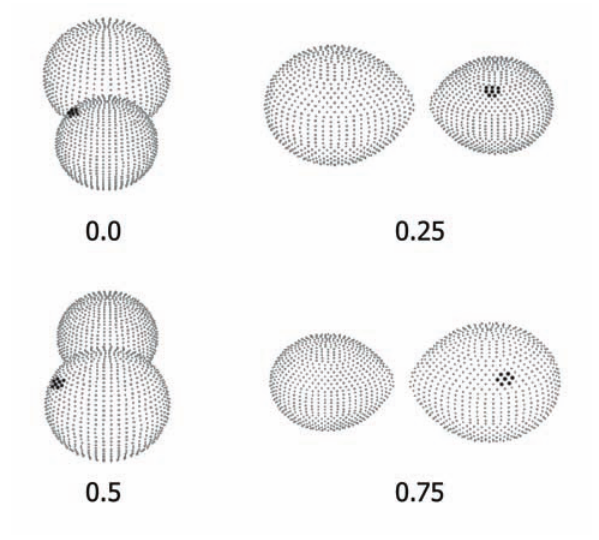
Fig. 6 A schematic spots modelling for IK